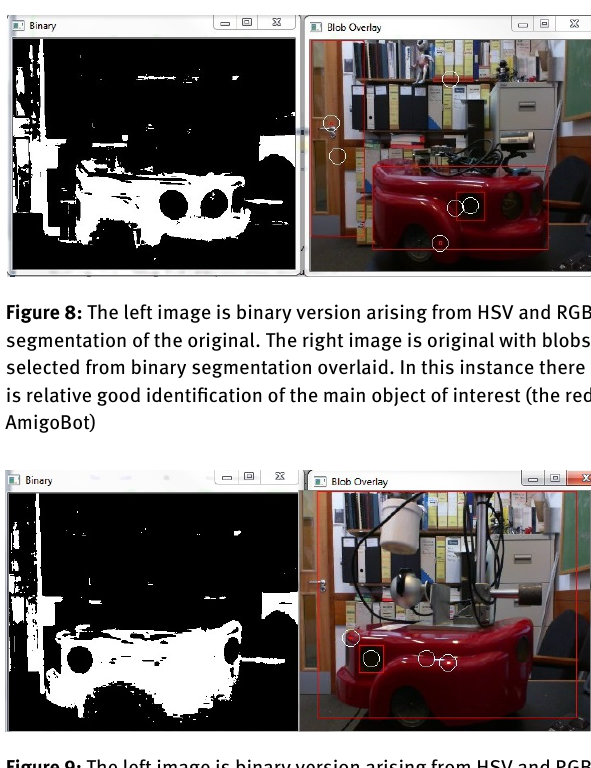
taken with the same camera under identical illumination levels. Figure 8 shows a red AmigoBot with minimal surface infrastructure. In this instance there is relative good identification of the main object of interest (the red AmigoBot). Figure 9 shows a red AmigoBot